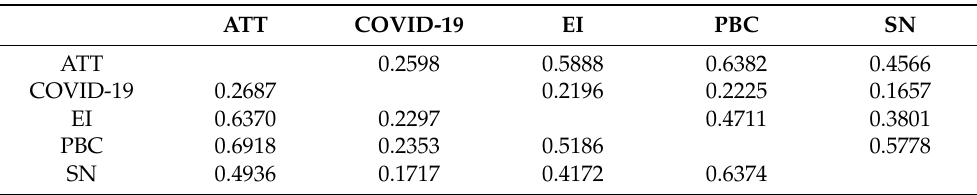
Table 3. Correlation matrix and discriminant validity—HTMT. ATT